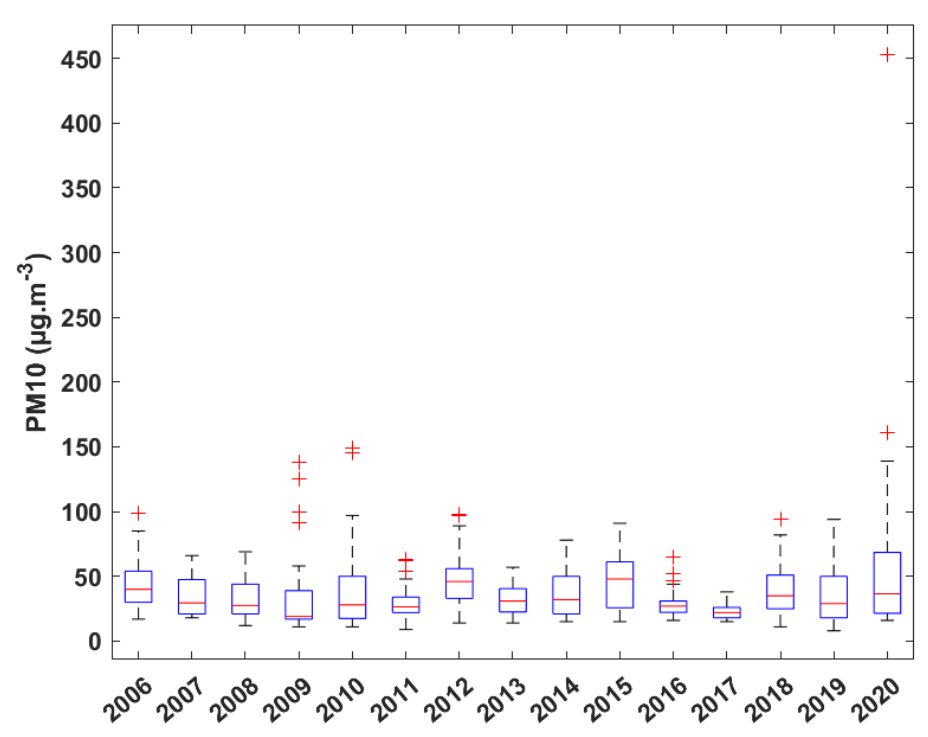
Figure 6. PM 10 box-plot with medians and outliers in PR for daily data in June from 2006 to 2020.